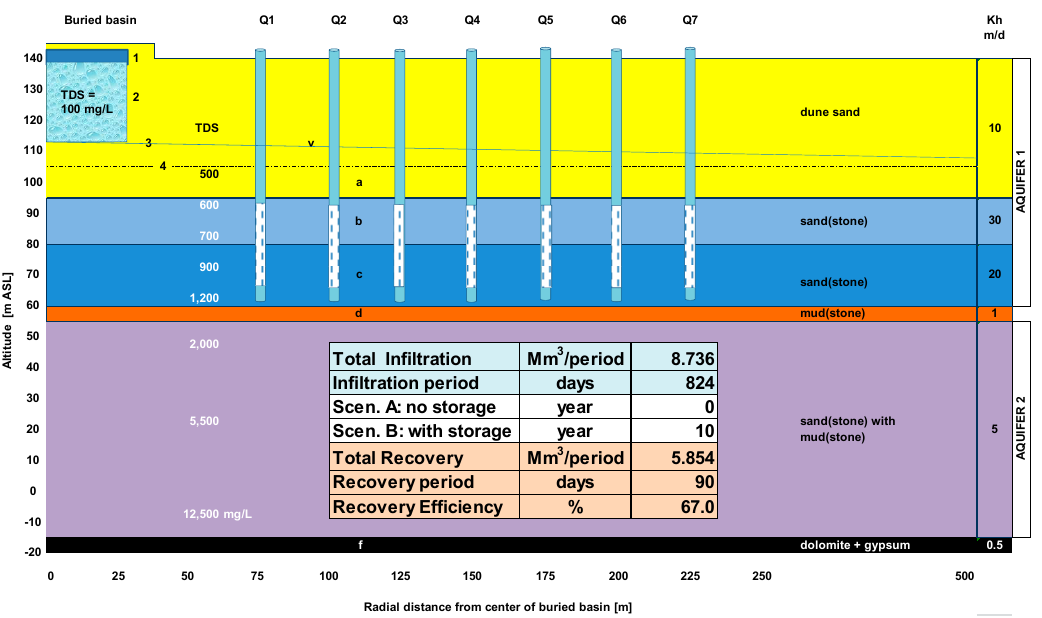
Figure 5. Schematic of each ASR well field (A, B or C) in the Strategic Water Storage and Recovery project in Liwa, with the planned ASR cycling scheme for each well field. Q1–Q7 = annular circle numbers 1–7 with 15 recovery wells each, surrounding the central infiltration basin. 1 = buried basin; 2 = unsaturated flow of infiltrated DSW; 3 = groundwater table during infiltration; 4 = groundwater table prior to recharge. a–f = aggregation of layers 1–14. d = aquitard 1, f = aquitard 2. Each well is supposed to pump from aquifer layers a, b and c in proportion to their transmissivity.